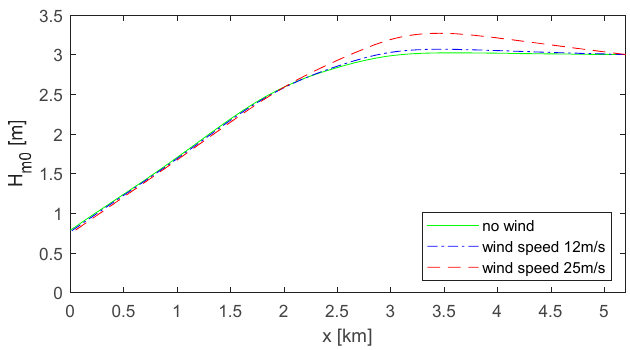
Figure 5. Wind effect on wave heights in SWAN for slope 1:500. Figure 5. Wind e ff ect on wave heights in SWAN for slope 1:500.